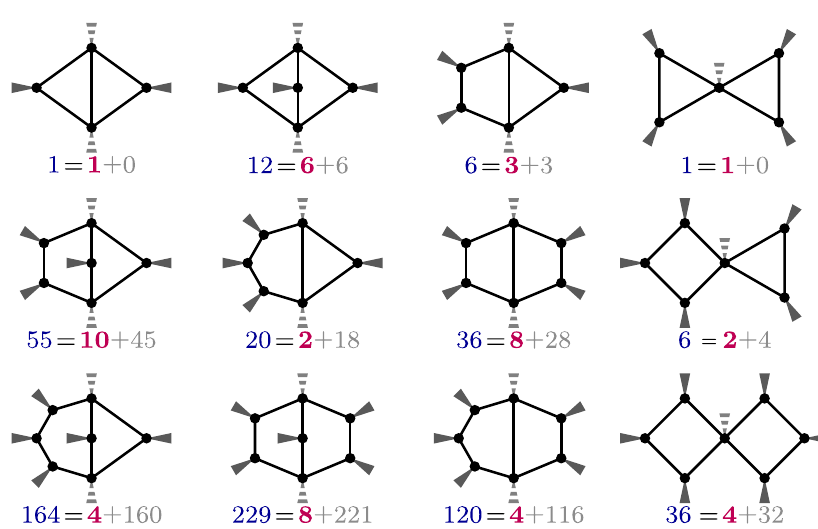
Table 1 . The starting point in our basis construction: the complete list of integrand topologies compatible with triangle power-counting, as defined in [21], reproduced from [32]. Included is the total rank of the vector space of numerators in B , as well as the decomposition of these ranks into 3 top-level and contact